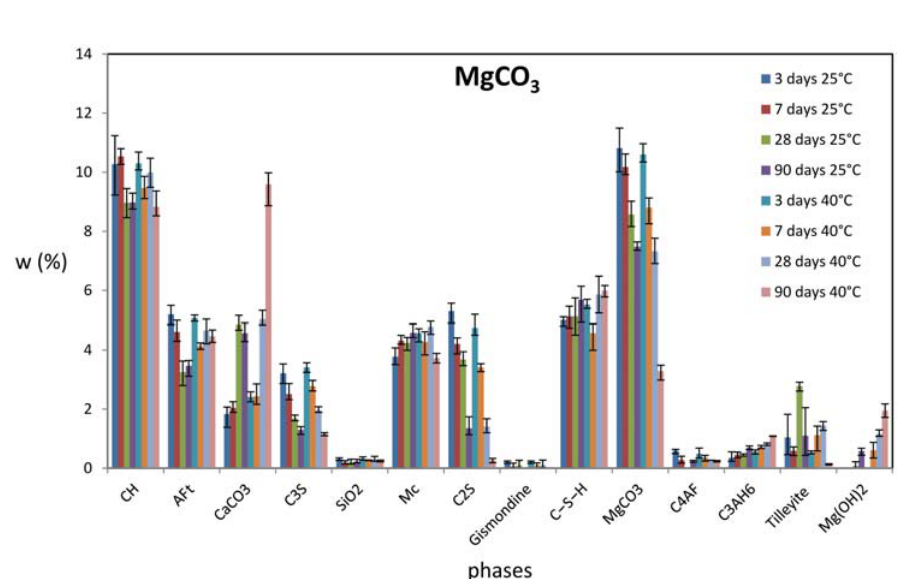
Figure 5. The quantitative determination of hydration products in cements with added MgCO 3 at 3, 7, 28 and 90 days of hydration and two temper- atures, 25 and 40